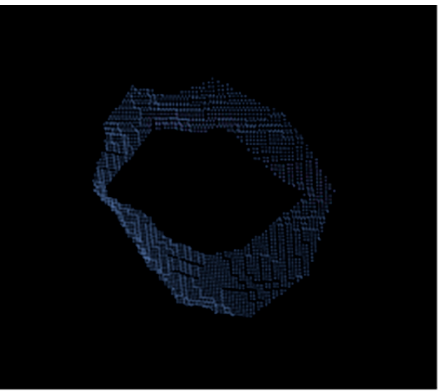
Figure 2. Example of lip area extraction from 3D point cloud.